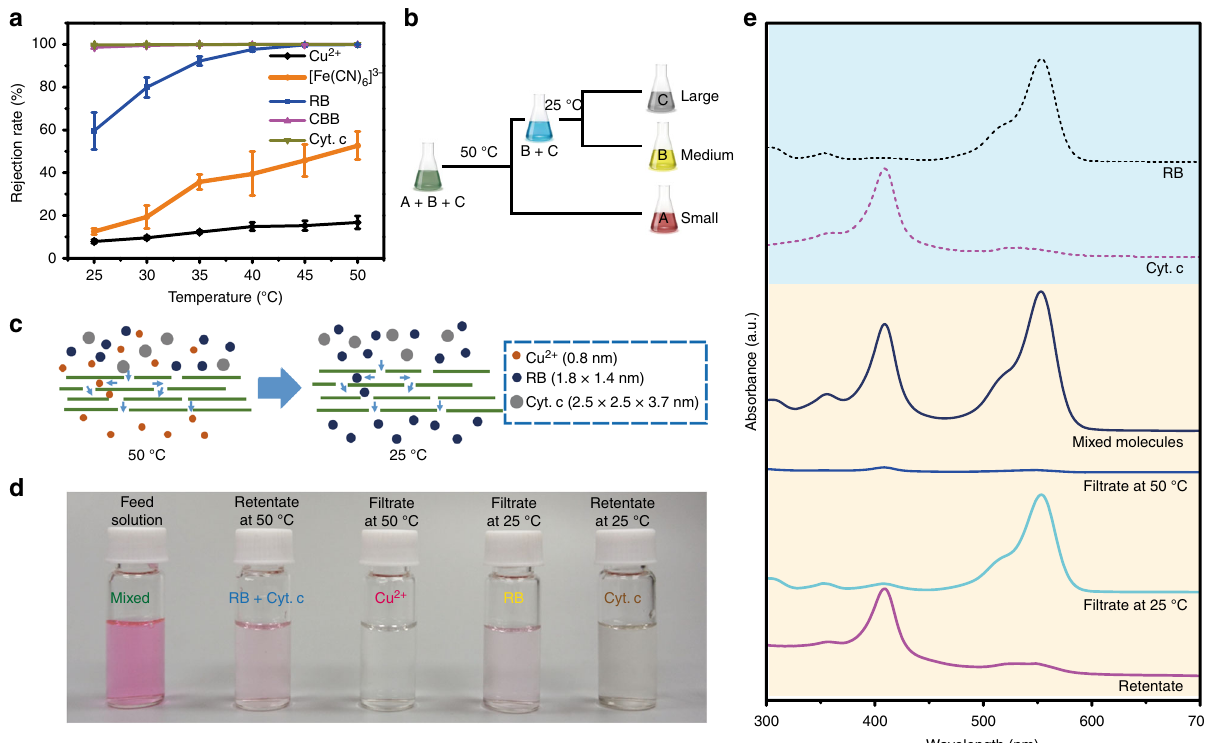
Fig. 6 P-GOMs for multiple molecules separation. a Temperature-dependent rejection rates of P-GOMs to Cu 2+ , [Fe(CN) 6 ] 3 − , RB, CBB, and Cyt. c, implying smaller channel size of the P-GOMs with the increasing temperature. Error bars, s.d. ( n = 3). b Schematic diagram of the separation mechanism of P-GOMs towards mixed molecules solution. c Separation of mixed molecules solution, containing Cu 2+ , RB, and Cyt. c. d The digital photos of the mixed molecules feed solution, retentate at 50 °C, fi ltrate at 50 °C, fi ltrate at 25 °C, and retentate at 25 °C. e The UV-vis absorption spectra of pure RB aqueous solution, Cyt. c aqueous solution, mixed molecules solution, fi ltrate obtained at 50 °C and 25 °C, and retentate at 25